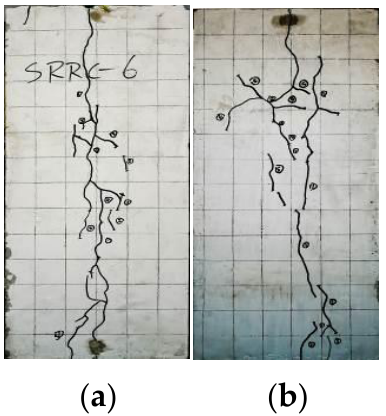
Figure 10. Branch cracks. ( a ) S-SFRAC06. ( b ) S-SFRRAC10.